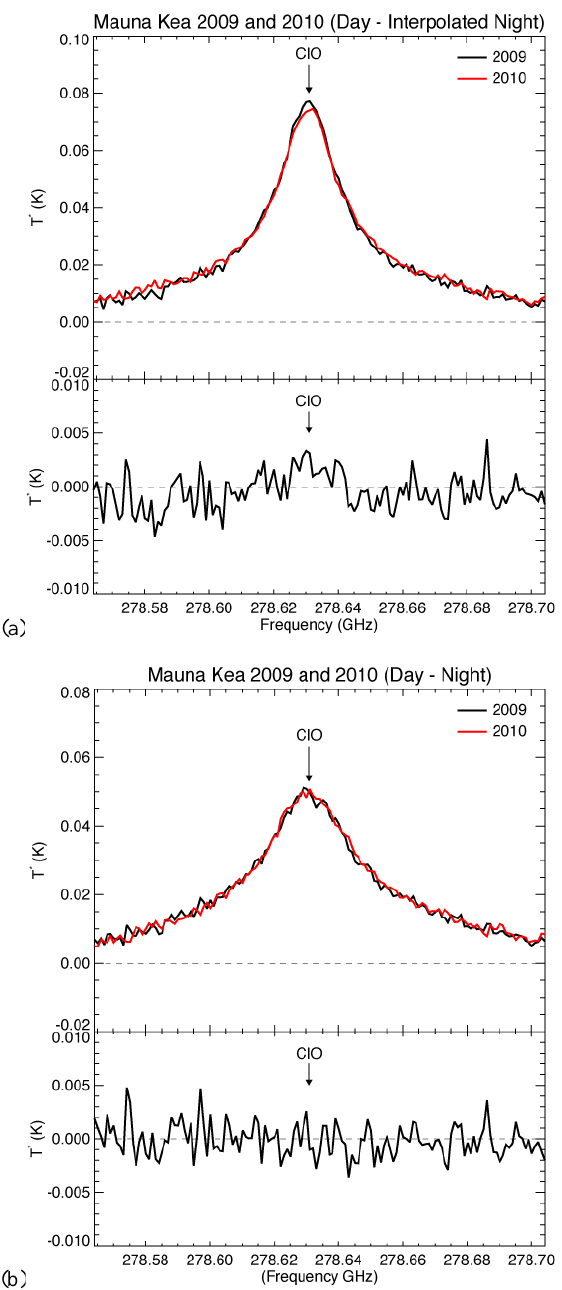
Figure 3b 519 Fig. 3. Day–“interpolated night” (a) and day–night (b) average 520 spectra for 2009 and 2010, and the difference of the 2 years.